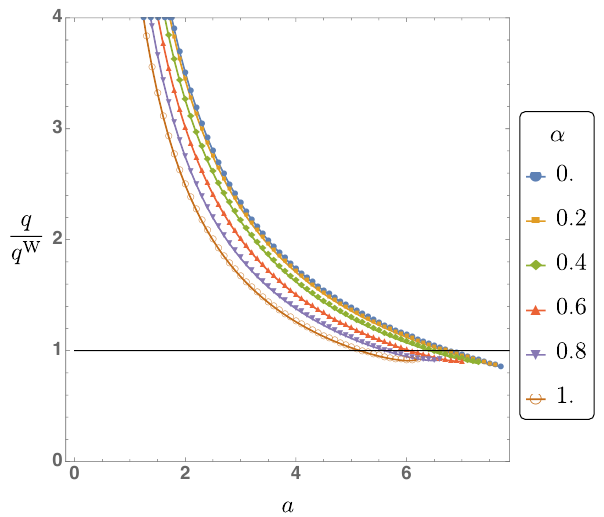
Figure 3 . Minimal charge q for condensing (cid:8) as a function of the boundary amplitude a for several values of the dilaton coupling (cid:11) , which are labelled on the